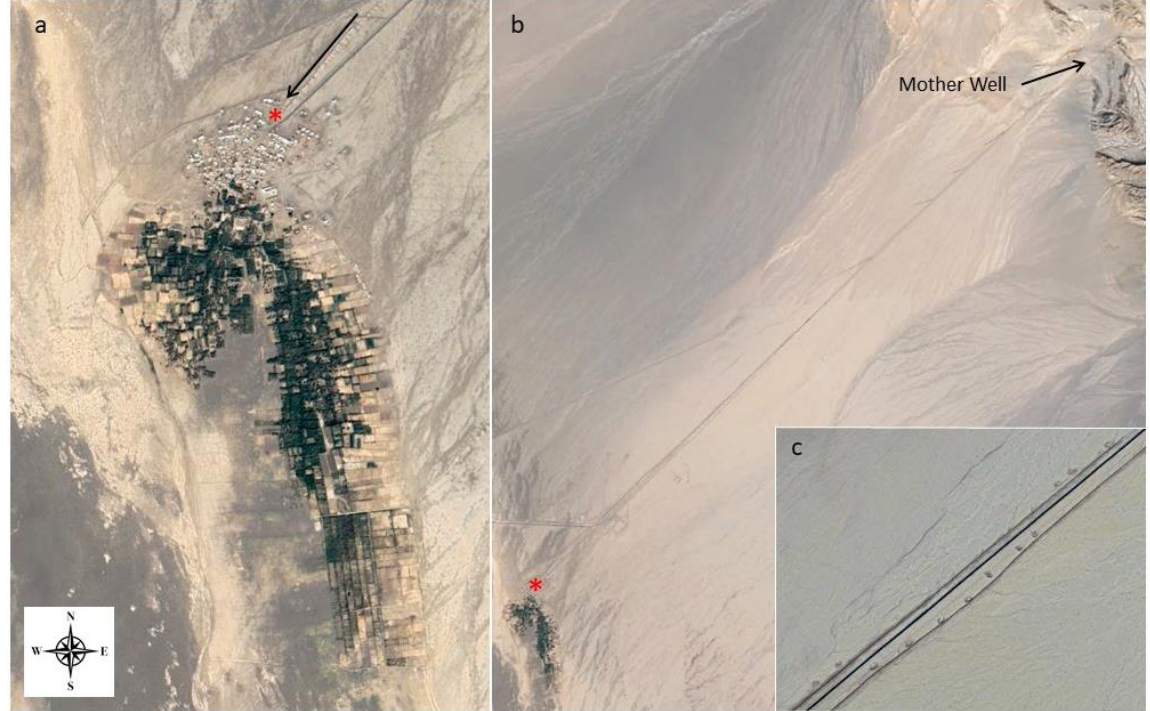
Figure 2. Google Earth images of the qanat serving the village of Deh Salm, South Khorasan Prov- ince, Iran, in late August of 2019. ( a ) View of the village and agricultural area. The arrow marks the location and trajectory of the incoming qanat, and the asterisk identifies the approximate site of the stream’s emergence at the upper edge of the settlement. Fields, many of them green, lie be- low the populated area. ( b ) Overview of the landscape above the qanat. The approximate site of the mother well is indicated by the arrow, and the exit area of the stream, as in ( a ), by an asterisk. ( c ). Enlargement of a segment of the qanat between the mother well and the settlement, showing the shaft openings and spoil heaps flanking a roadway that parallels the